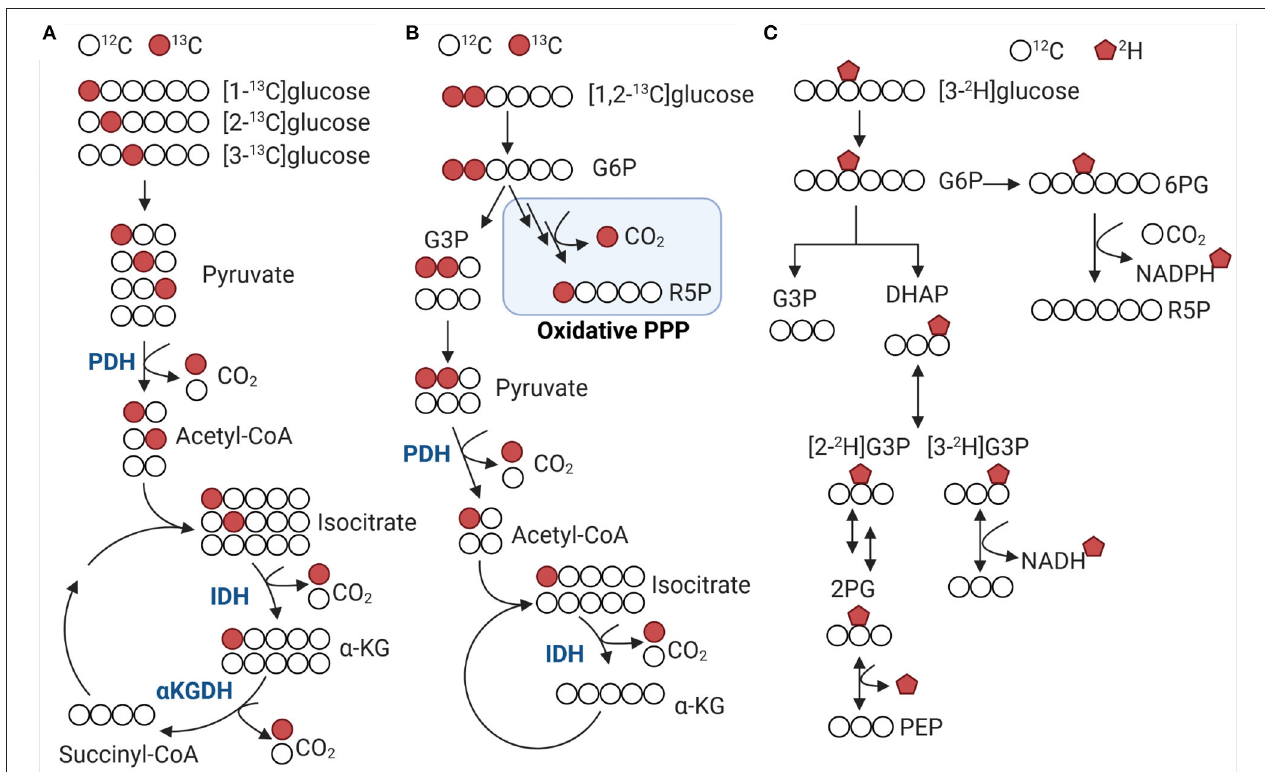
FIGURE 2 | 13 C and 2 H distribution from labeled glucose in glycolysis and Krebs cycle. (A,B) 13 C-glucose is decarboxylated at different steps in the Krebs cycle and oxidative pentose phosphate pathway. Colored circles indicate 13 C label for selected metabolic intermediates. [2- 13 C]glucose and [3- 13 C]glucose are associated with pyruvate dehydrogenase (PDH) activity producing m + 2 and m + 3 acetyl-CoA, respectively. Using [1,2- 13 C]glucose allows to distinguish between glycolysis and oxidative pentose phosphate pathway (PPP) flux. (C) [3- 2 H]glucose enters the PPP via glucose 6-phosphate (G6P) and decarboxylated to ribulose 5-phosphate (R5P), which generates 2 H-NADPH. DHAP, dihydroxyacetone phosphate; G6P, glucose 6-phosphate; G3P, glyceraldehyde 3-phosphate; IDH, isocitrate dehydrogenase; α -KG, α -ketoglutarate; α -KGDH, α -Ketoglutarate dehydrogenase; PDH, pyruvate dehydrogenase; PPP, pentose phosphate pathway; 6PG, 6-phosphogluconate; 2PG, 2-Phosphoglycerate; PEP, phosphoenolpyruvate; R5P, ribulose